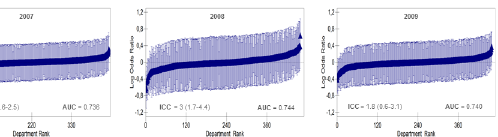
Fig 1. Ranking of the 565 Swedish departments for the three years (A-C) accordingto their one-year mortality after hospitalization for heart failure (2007–2009) using the overall averageas reference. Valuesare logarithmodds ratios (i.e., shrunken residuals) with 95% confidenceintervals (vertical lines) adjustedfor age, genderand risk score (see model 2 in Table 3). The figure also indicatesthe values of the departments intra- class correlationcoefficients (ICC) for one-yearmortality and the